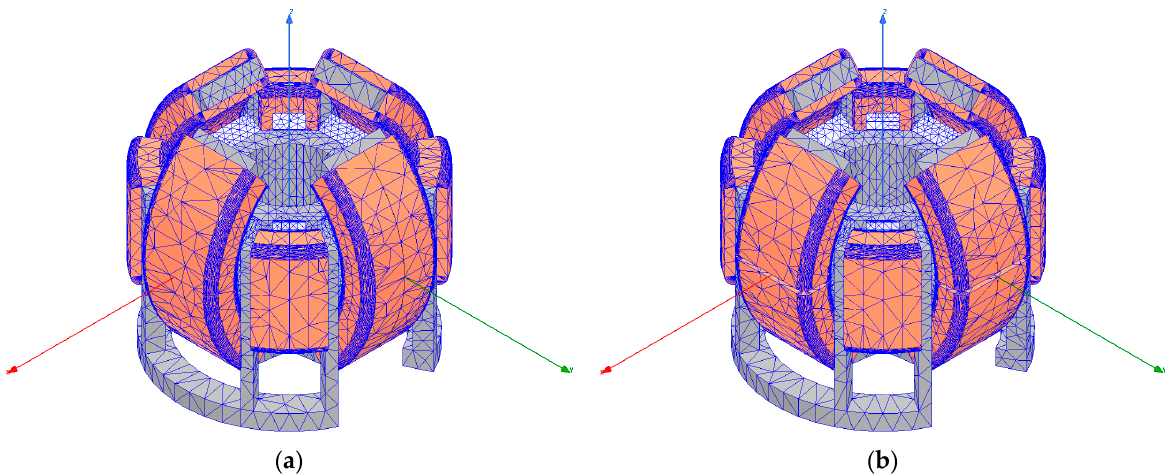
Figure 7. 3D FEM models of ( a ) original and ( b ) proposed 3-DOF spherical motor, respectively.